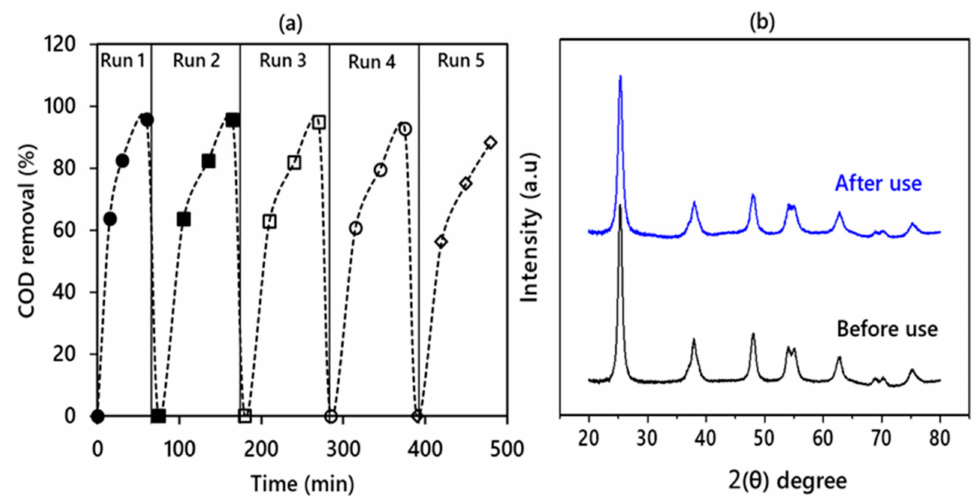
Figure 11. ( a ) Recyclability of the CNB-TiO 2 after five repeated runs and ( b ) XRD patterns of black CNB-TiO 2 before and after sonophotocatalytic